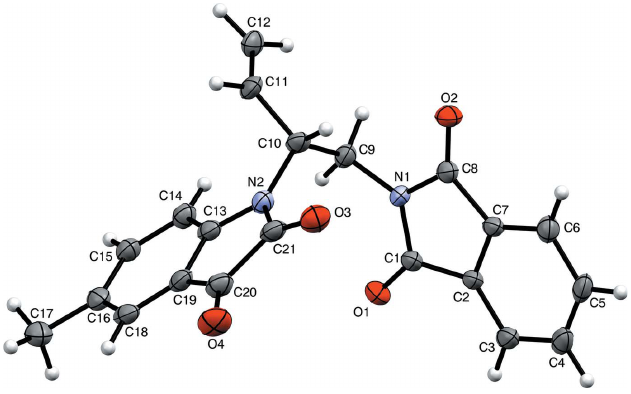
Figure 6 An ellipsoid plot (50% probability) of one representative molecule of WUGLES (out of six independent molecules in the asymmetric unit), generated using Mercury (Macrae et al. , 2020).